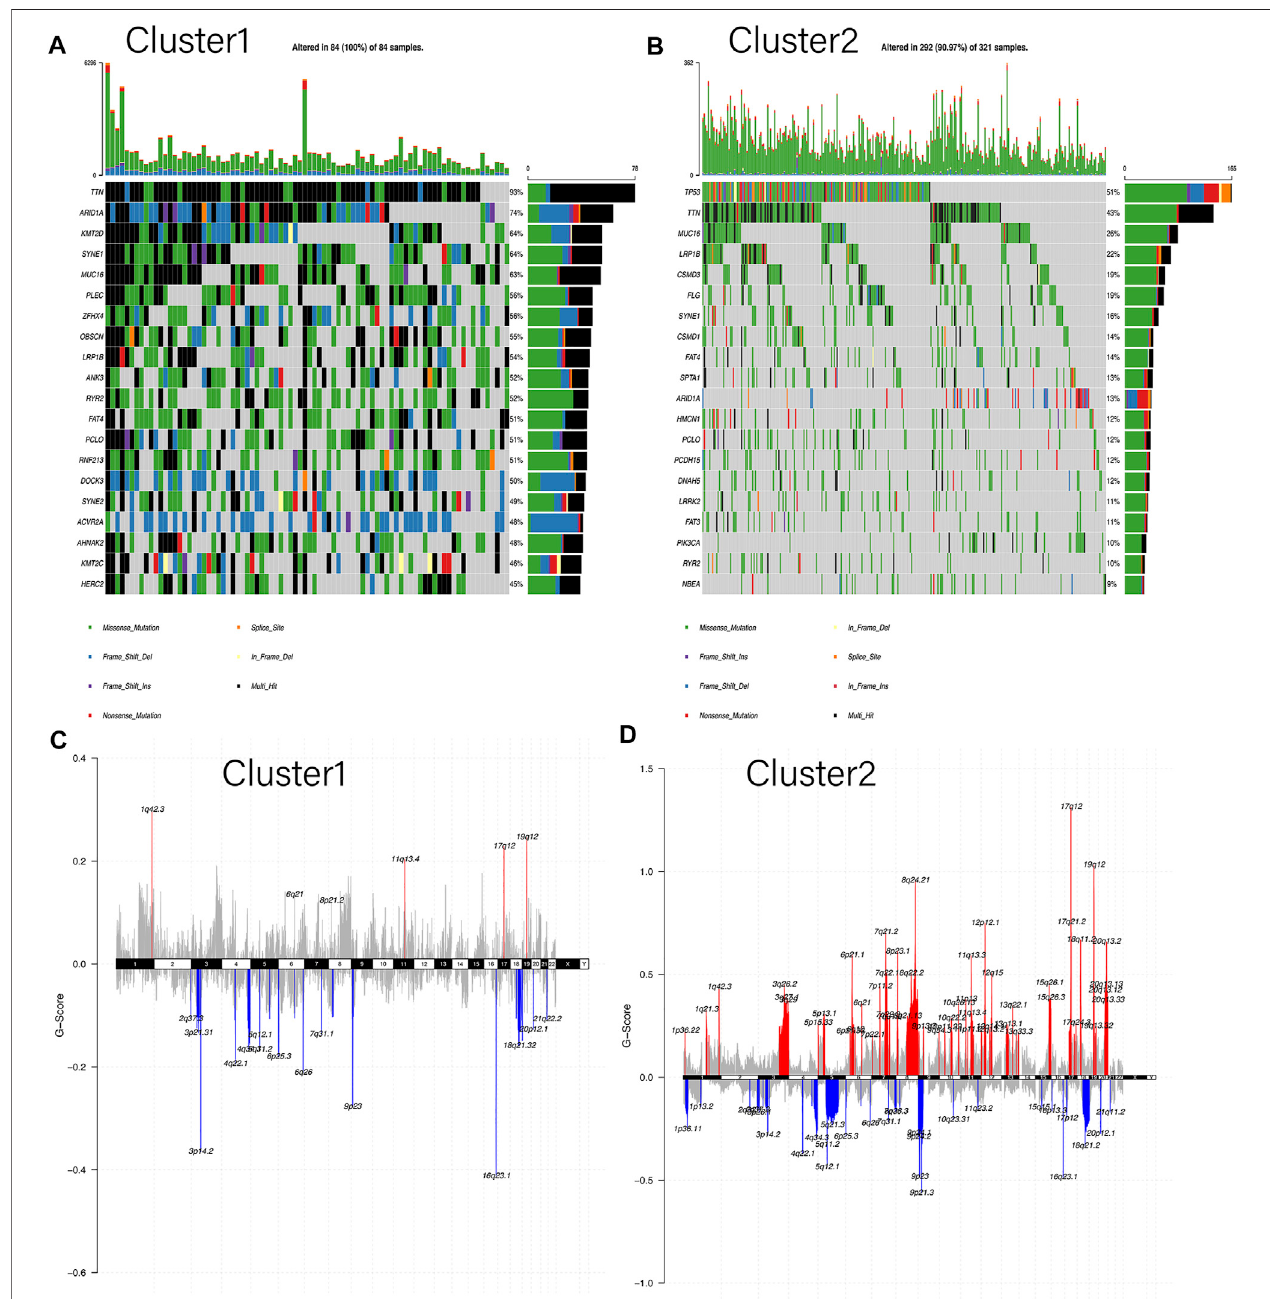
FIGURE 4 | Differences in somatic mutation and copy number alteration between the two subgroups. (A,B) Oncoplot indicated the top 20 mutated genes in both Cluster1 and Cluster2, respectively. Different colors represent different mutation types. (C,D) Cumulative CNA regions for Cluster1 and Cluster2, respectively. Ampli fi cation was represented in red color, and deletion was represented in blue